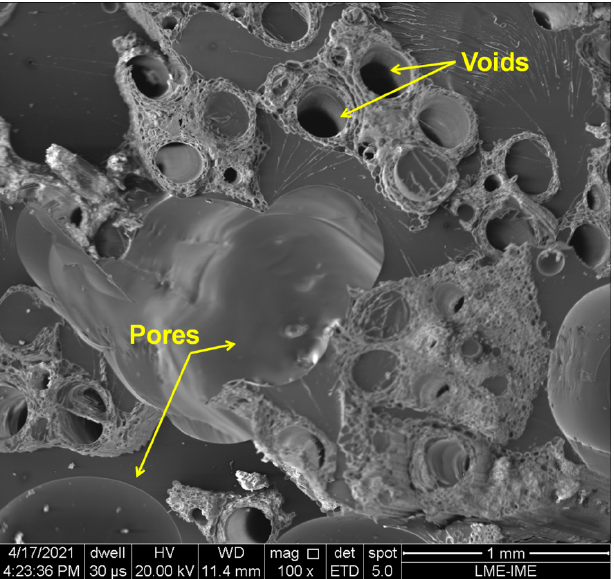
Figure 10. SEM images of cross-sections of untreated 30 vol% TVF composite.